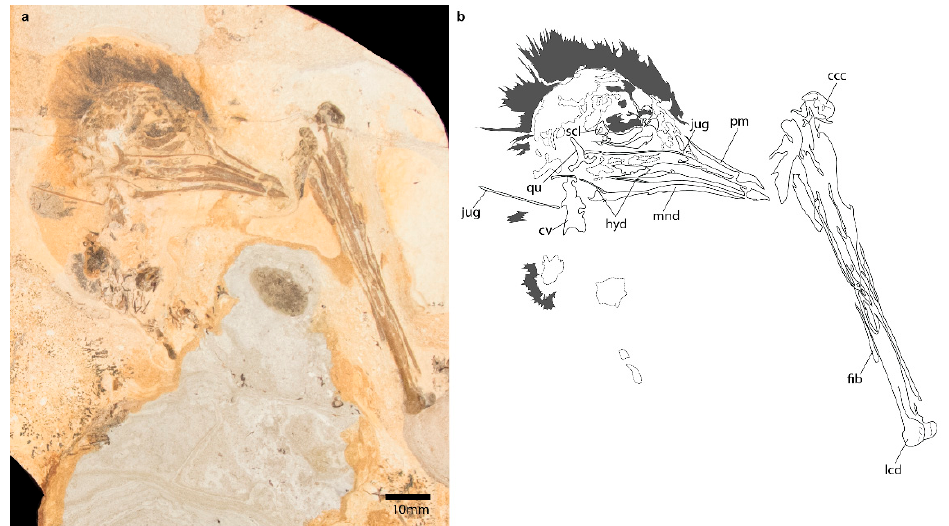
Figure 3. Photograph ( a ) and line drawing ( b ) of referred specimen of Pellornis mikkelseni , DK664. Soft tissue and plumage is filled in with gray. Dashed borders indicate bone that is extremely broken. Anatomical abbreviations: pm premaxilla, scl scleral ossicles, qu quadrate, jug jugal, mnd mandible, hyd hyoids, cv cervical vertebrae, ccc crista cnemialis cranialis, fib fibula, lcd lateral condyle (of tibiotarsus).